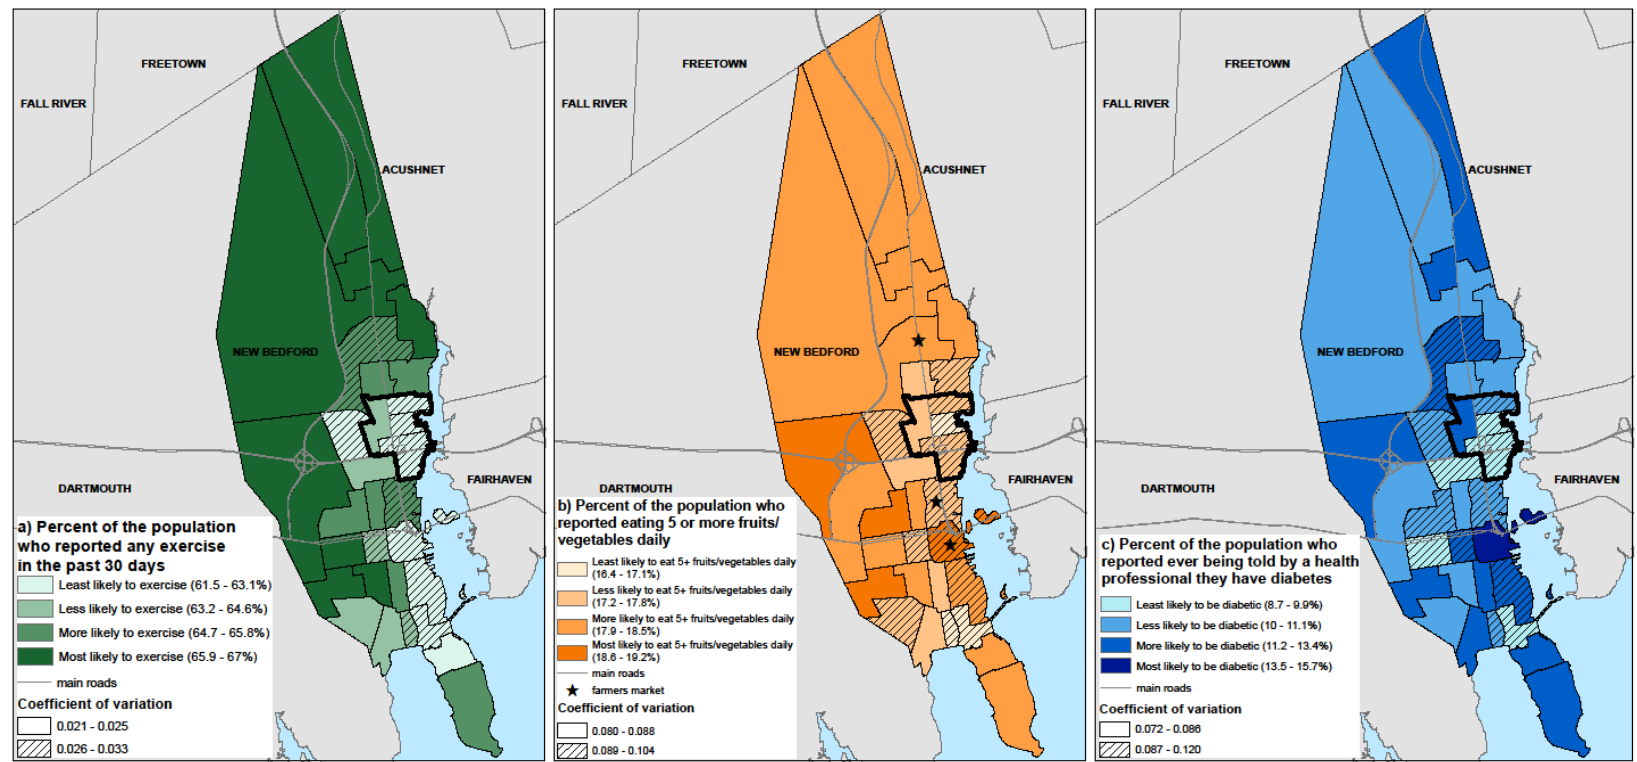
Figure 1. ( a–c ) Predicted exercise, fruit and vegetable consumption and diabetes prevalence by census tract in New Bedford, MA estimated using synthetic population microdata. Black outlined census tracts were identified as high priority by community partners. Coefficients of variation around each predicted outcome at the census tract level were calculated by running a Monte Carlo simulation of each model 1000 times to quantify uncertainty. Data sources: exercise, fruit/vegetable and diabetes proportions modeled from MA BRFSS 2005–2010 and applied to synthetic population microdata [10].